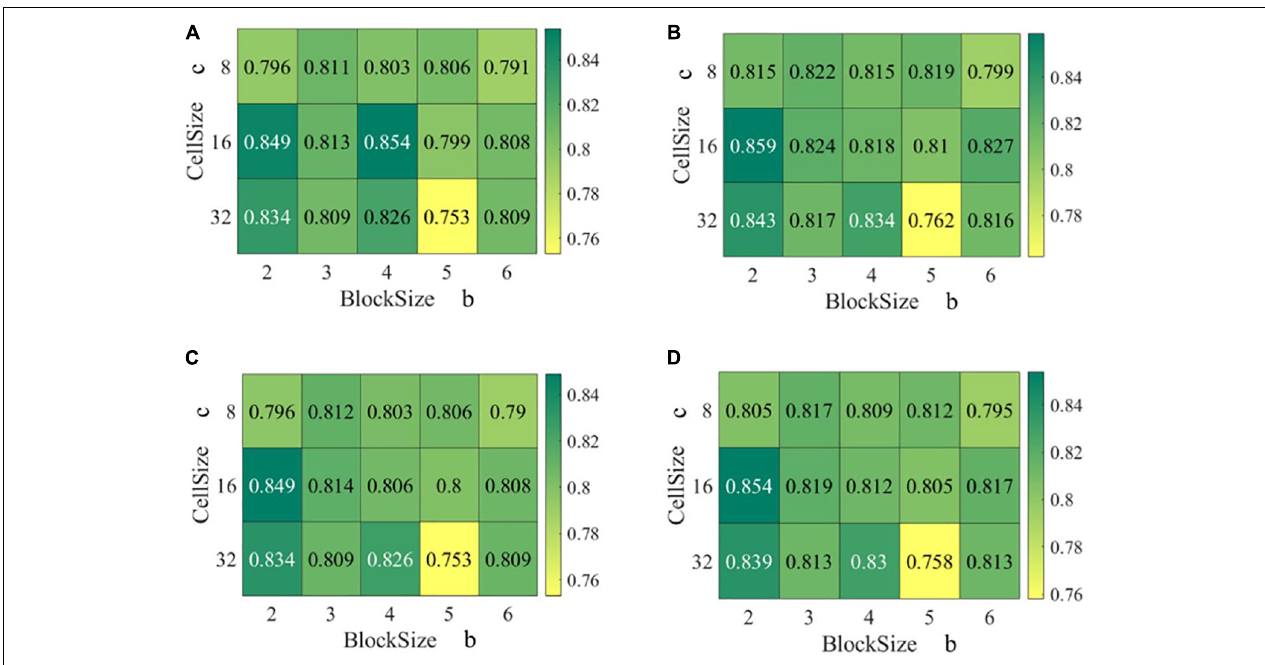
FIGURE 6 | Evaluation performance on the validation sets for SVMs trained on the HOG features as a function of cell size c and block size b : (A) Accuracy, (B) average precision, (C) average recall, and (D) F1